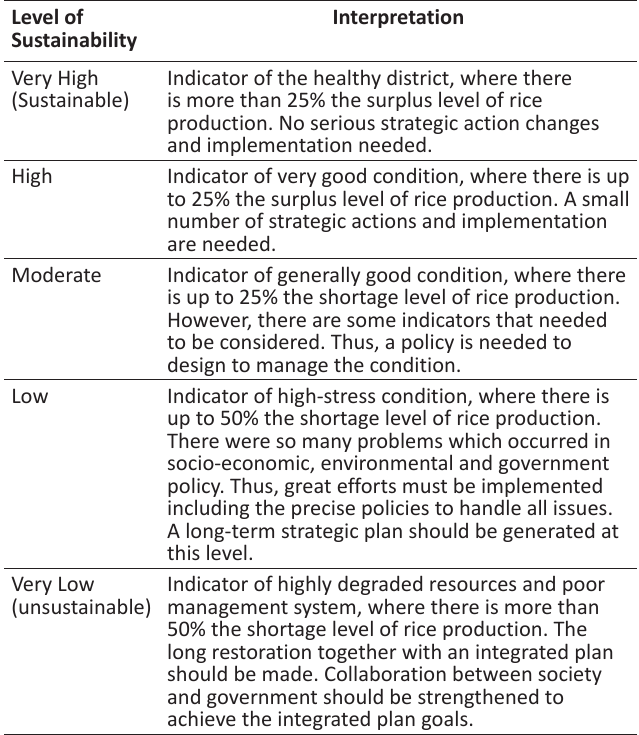
Table 3 . Classification and interpretation of rice production sustainability